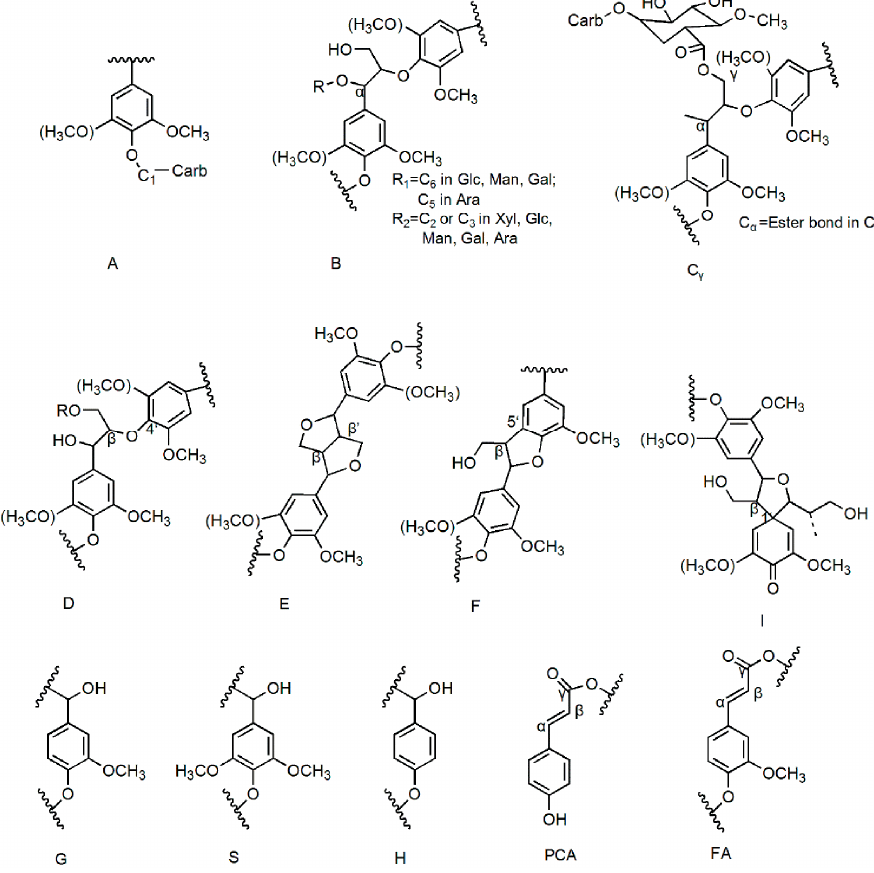
Figure 3. Main structures present in the LCC preparations: (A) phenyl glycoside; (B) benzyl ether; (C) ester (C α , α -ester; C γ , γ -ester); (D) β - O -4 substructure; (E) β - β resinol substructure; (F) β -5 phenylcoumaran substructure; (I) β -1 spirodienone substructure; (G) guaiacyl unit; (S) syringyl unit; (PCA) p -coumarate; (H) p -hydroxyphenyl unit; (FA) ferulate unit. Table 4. Assignments of primary lignin and carbohydrate 13 C– 1 H cross-signals in the HSQC spectra of the LCC preparations from bamboo ( Neosinocalamus affinis ).